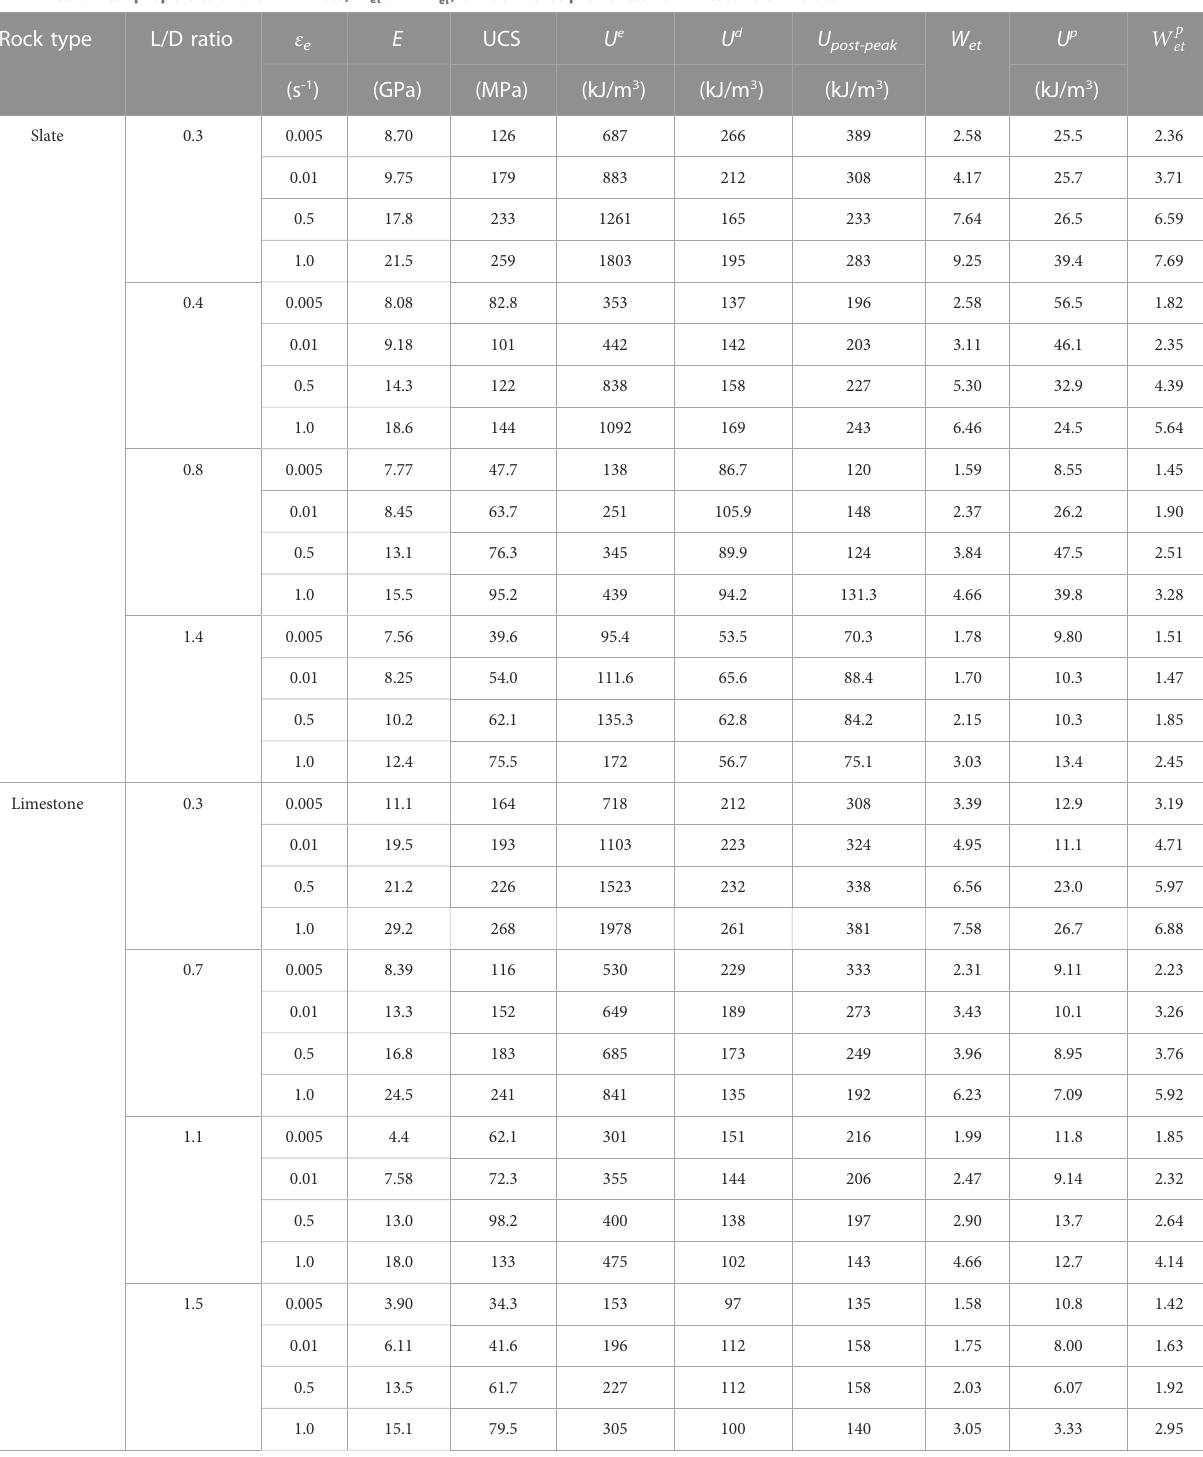
fi tting coef fi cient R 2 ranged from 0.94 to 0.99, indicating an accurate linear correlation between the energy storage and dissipation. For slate and limestone, the slope value of U e versus U represents the storage ability of elastic energy. The fi gure demonstrates that the energy storage ability of slate was stronger than that of limestone (slope values were 0.93 and 0.71 for slate and limestone, respectively). The difference in slope value is related to the